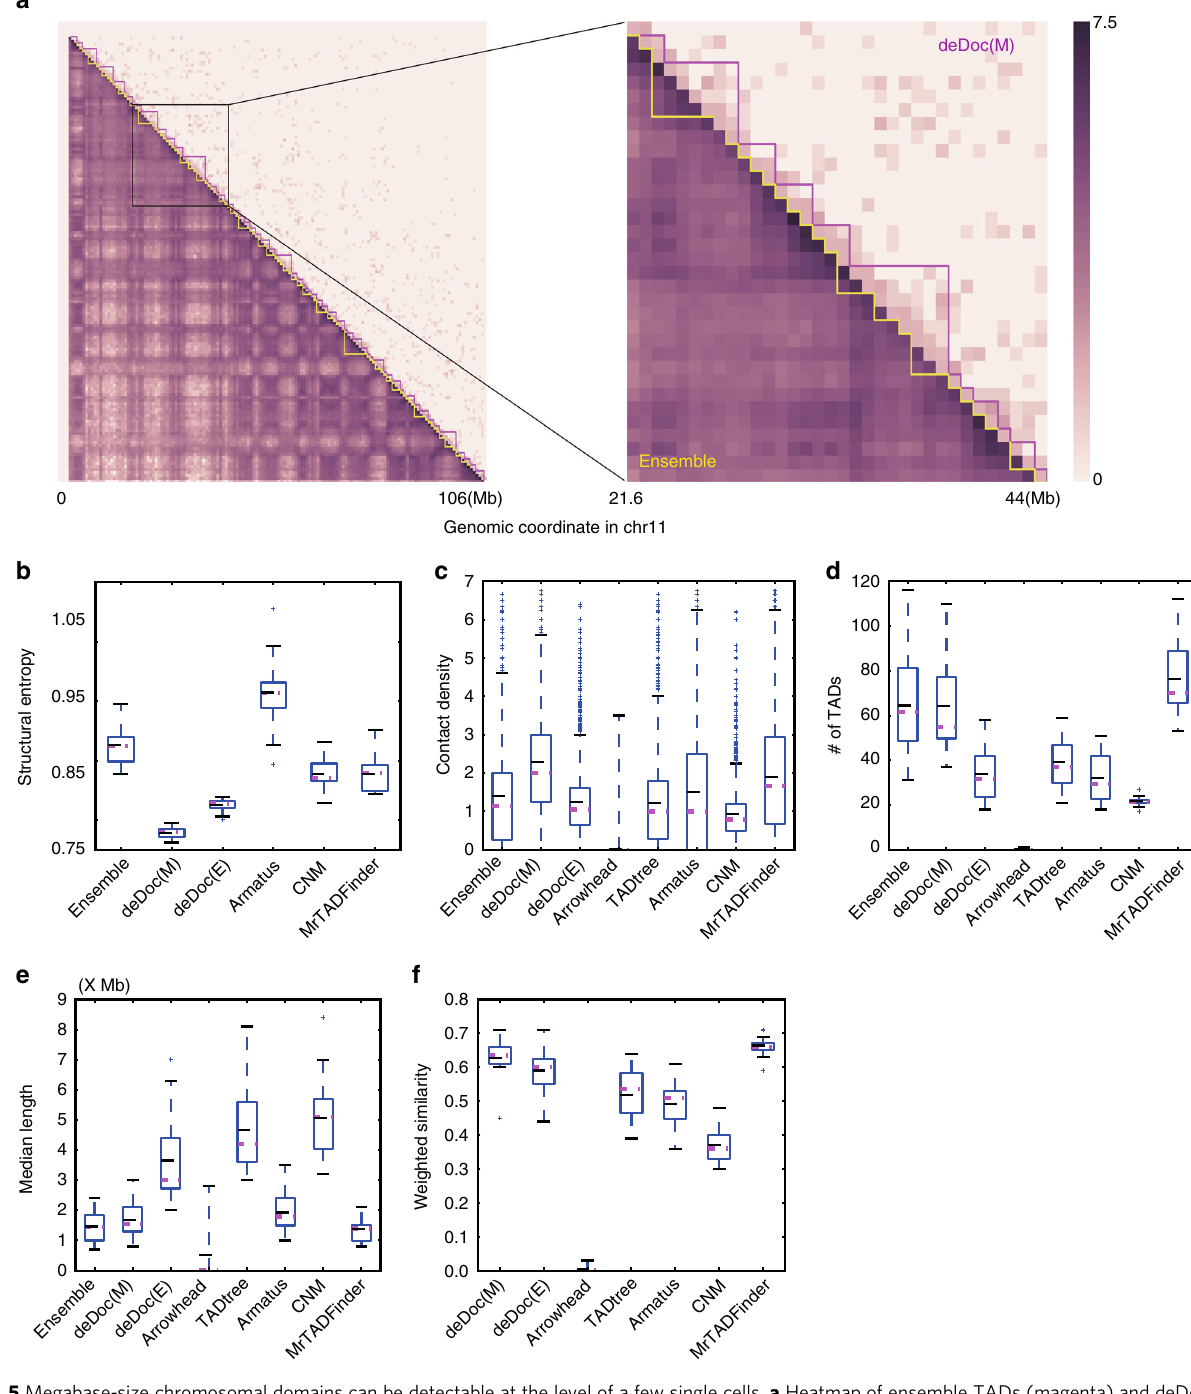
Fig. 5 Megabase-size chromosomal domains can be detectable at the level of a few single cells. a Heatmap of ensemble TADs (magenta) and deDoc(M) domains predicted from data Hi-C pooled from 10 single cells (yellow). b – e Box plots of b the SEs, c intra-domain contact density, d the number, and e the length of the domains as predicted by the algorithms using the pooled Hi-C data. f WSs between the reference and the predicted domains. Box plot quartiles, and the means and medians of each dataset are indicated by black and magenta lines, respectively. The ends of the up and down whiskers represent the highest and lowest datum or 1.5 interquartile range of the upper and lower quartiles,